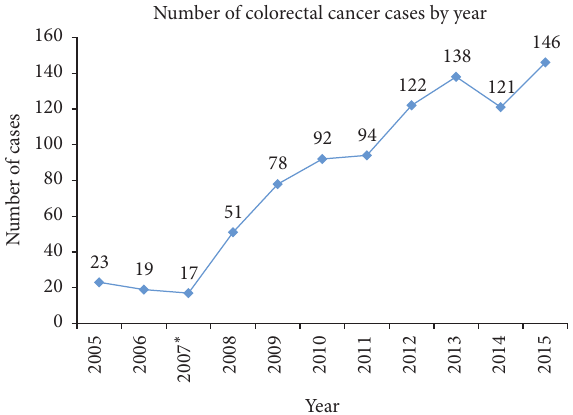
Figure 5: CRC cases distribution by year. ∗ shows that there were missing records in that year from Ocean Road.